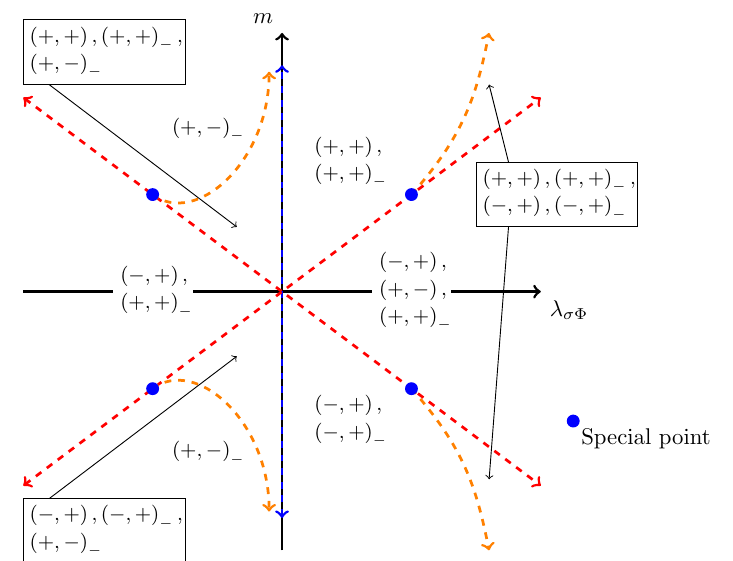
Figure 10. Phase diagram of the theory (2.3) with decoupled gauge sector λ → 0 in the case sign ( j ) = − 1 . More general cases with small λ are governed by the superpotential σ λ σ